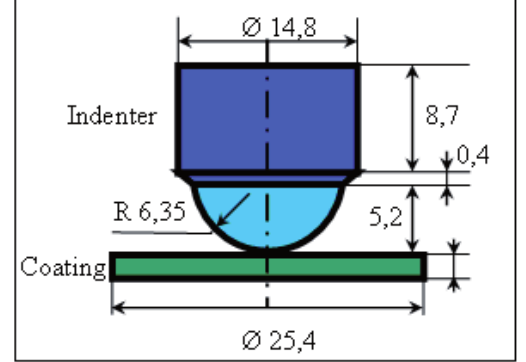
Fig. 3. Schematic of HR15Y test rig.